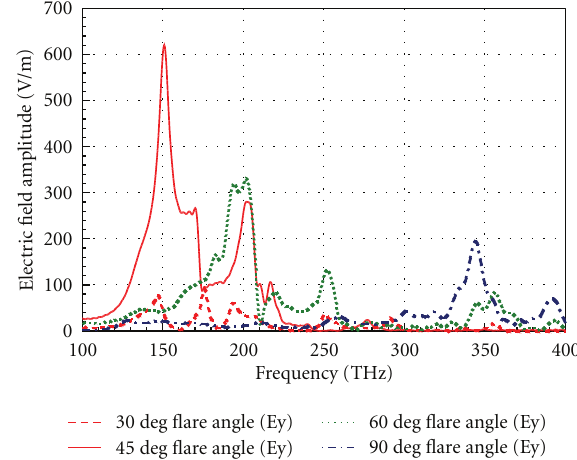
Figure 8: Electric field component along y -direction at the feed gap location of double bowtie antenna for y -polarized unity strength plane wave